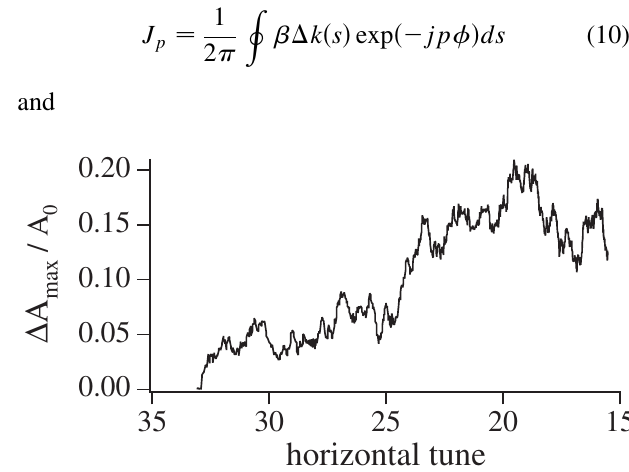
FIG. 9. (Color) Distribution of maximum distortion defined by the fixed and fitted lattice functions out of 501 different gradient errors. Initial emittance is 30 (cid:1) mm rad .